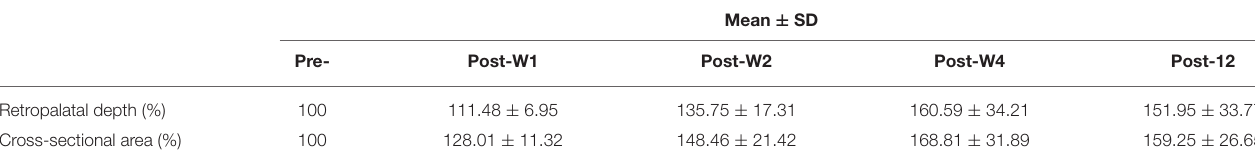
TABLE 2 | Pre-operative and post-operative retropalatal depth (%) and CSAOI (%)